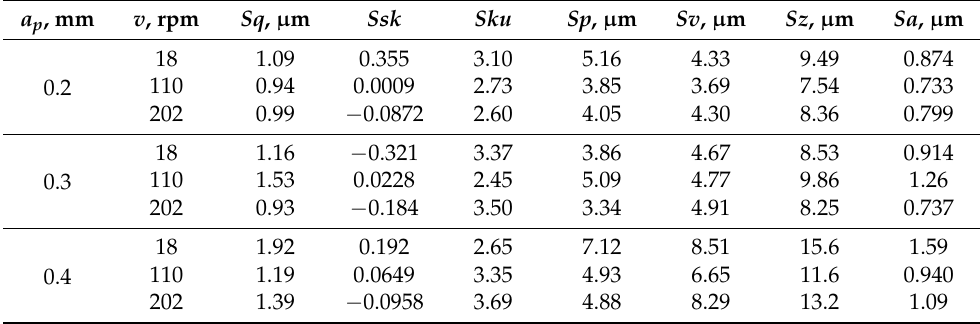
in Table 6. The smallest error values were observed for networks learned with the quasi- Newton algorithm. The number of learning epochs necessary to reach the minimum error value was about 80 for the quasi-Newton algorithm, 140 for the backpropagation algorithm and 170 for the network trained using the Levenberg–Marquardt